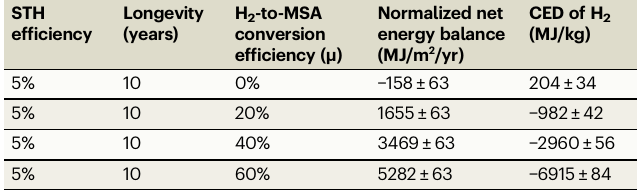
Theerror valuesprovided forthe normalizednet energybalance and thecumulative energy demand(CED) ofH 2 were obtained from theuncertainty